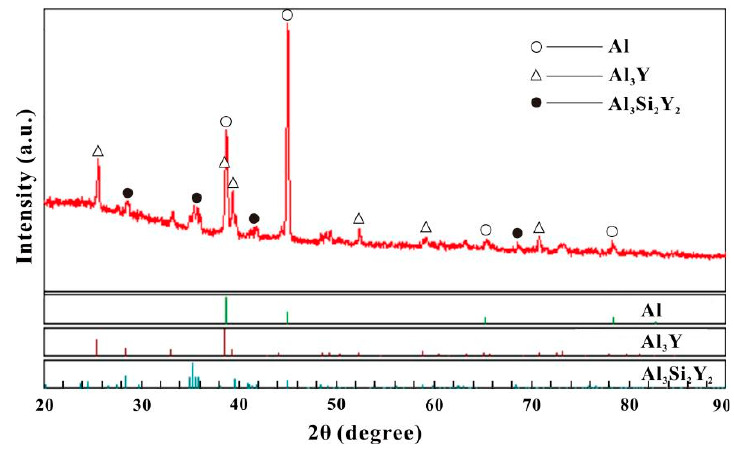
Figure 6. XRD pattern of alloy sample No. 26.